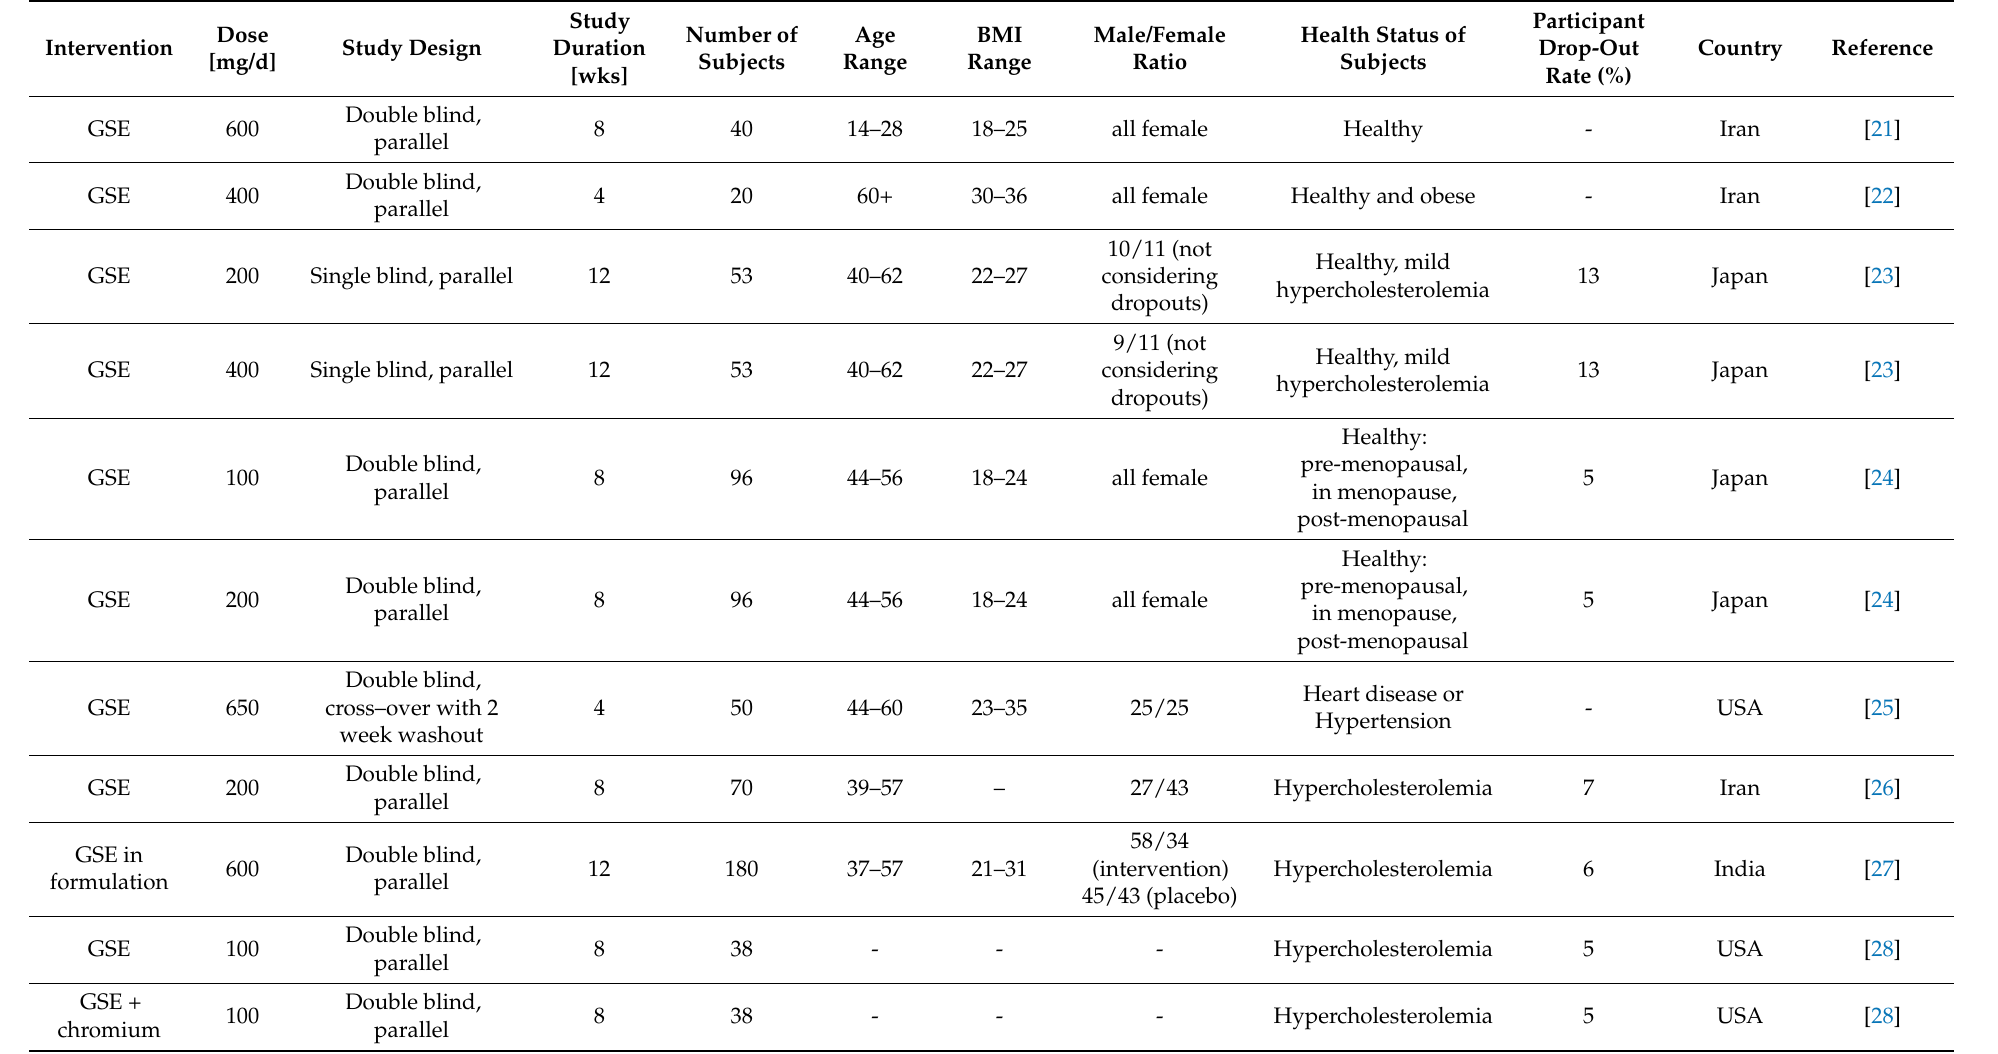
Table 1. Overview of supplement studies with grape seed or bilberry